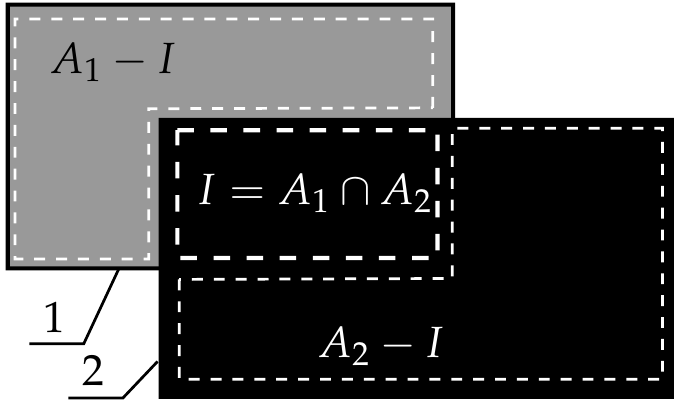
Figure 7. Component 2 with total area A 2 is overlapping component 1 with total area A 1 . The intersection area is I